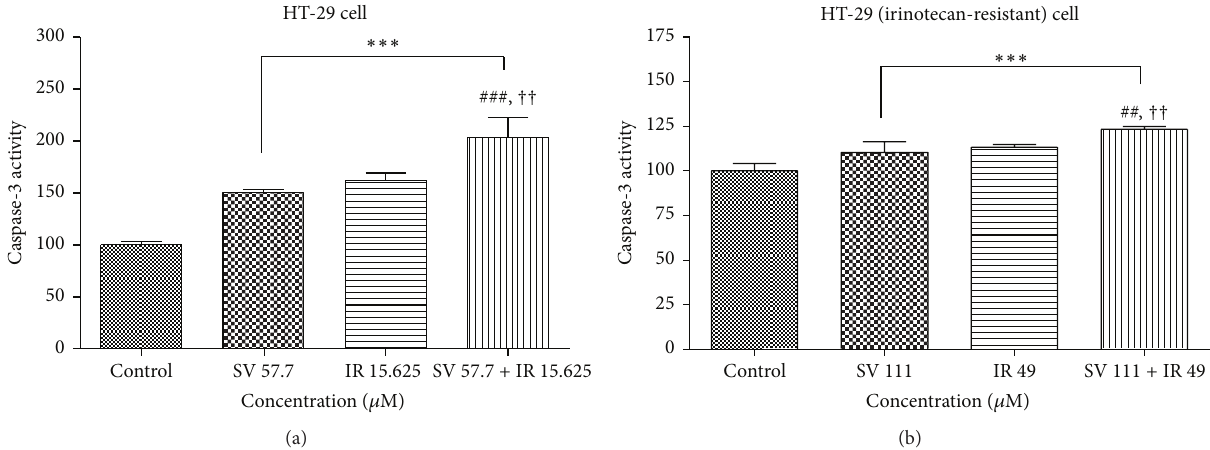
Figure 6: Synergistic effect of simvastatin and irinotecan on caspase-3 activity in HT-29 cell and irinotecan-resistant HT-29 cells. The spectrophotometric assay of caspase-3 activity was carried out as described in Section 2. HT-29 cells were treated for 48 h with simvastatin (SV) alone, irinotecan (IR) alone, and combination of SV and IR at 2 : 1 molar ratio in which the concentration of SV and IR was 57.7 𝜇 M and 15.625 𝜇 M, respectively (a). Following each drug treatment for 48 h, the spectrofluorometric assay of caspase-3 activity was carried out. The data are expressed as the means ± SD from three independent experiments. ∗∗∗ 𝑃 < 0.001 , compared to untreated control cells; ### 𝑃 < 0.001 , compared to SV alone; †† 𝑃 < 0.05 , compared to IR alone. HT-29R cells were treated for 48h with SV alone, IR alone, and combination of SV and IR at 2: 1 molar ratio in which the concentration of SV and IR was 111 𝜇 M and 49 𝜇 M, respectively (b). Following each drug treatment for 48 h, caspase-3 activity was determined spectrophotometrically using a multiplate reader (DTX 880 Multimode Detector). Increased caspase- 3 activities were evident in combination treatment group of the cells relative to untreated control and single treatment of SV or IR in HT-29 cells (a) and HT-29R cells (b). The data are expressed as the means ± SD from three independent experiments. ∗∗∗ 𝑃 < 0.001 , compared to untreated control cells; ## 𝑃 < 0.05 , compared to SV alone; †† 𝑃 < 0.05 , compared to IR